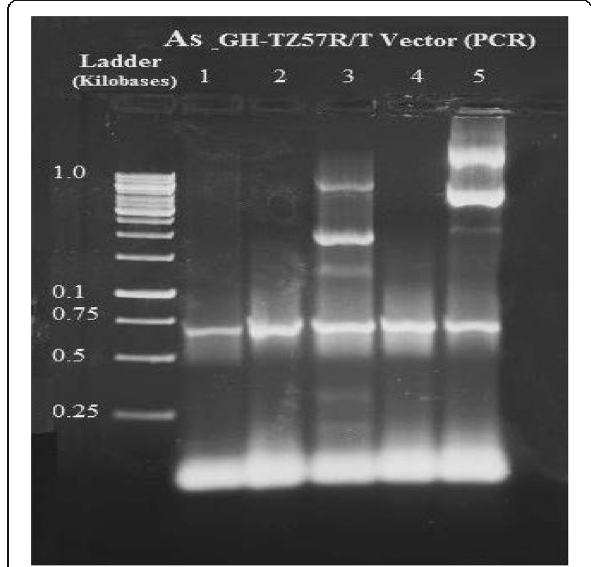
Fig. 3 PCR electrophoresis of As_GH-TZ57R/T vector